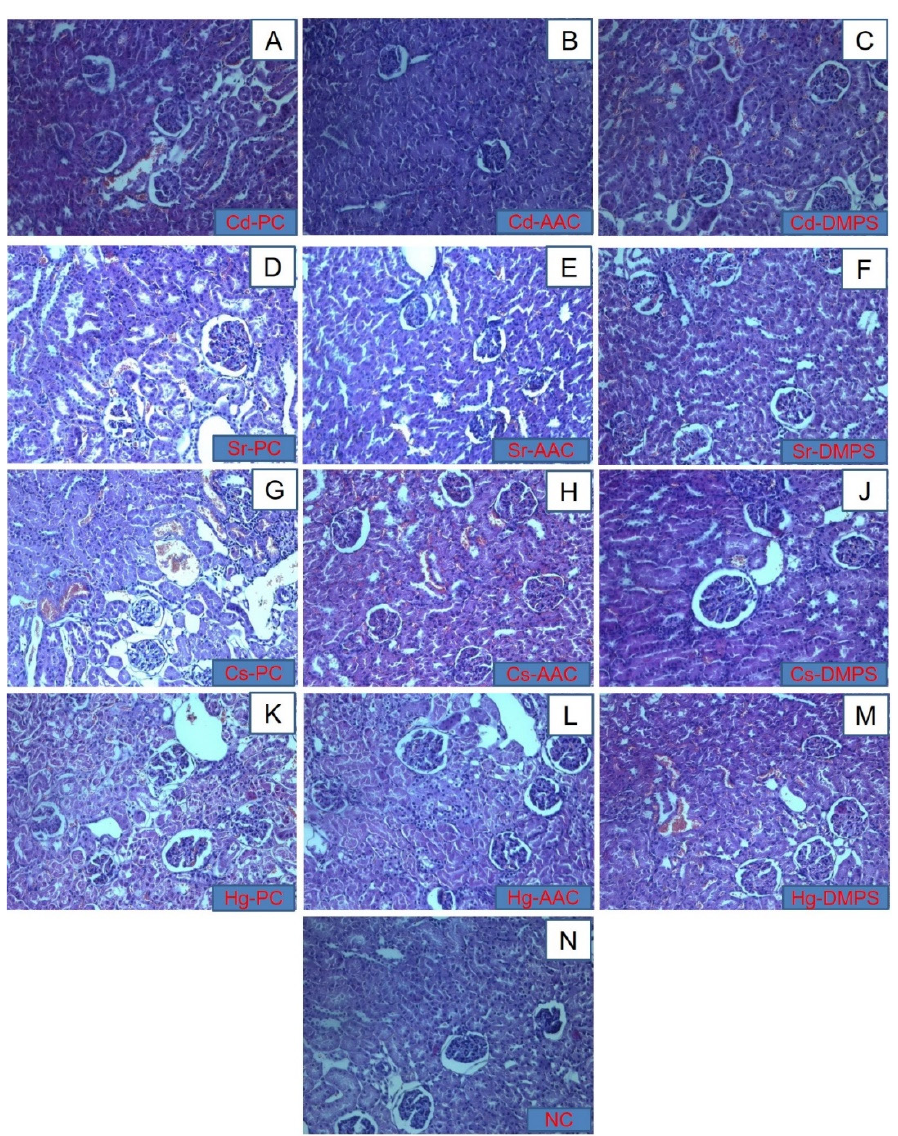
Figure 4. Histological images of kidneys of ( A ) Cd-PC, ( B ) Cd-AAC, ( C ) Cd-DMPS, ( D ) Sr-AAC, ( E ) Sr-AAC, ( F ) Sr-DMPS, ( G ) Cs-PC, ( H ) Cs-AAC, ( J ) Cs-DMPS, ( K ) Hg-PC, ( L ) Hg-AAC, and ( M ) Hg-DMPS subgroups and the ( N ) NC group at 100× magnification, H&E staining.